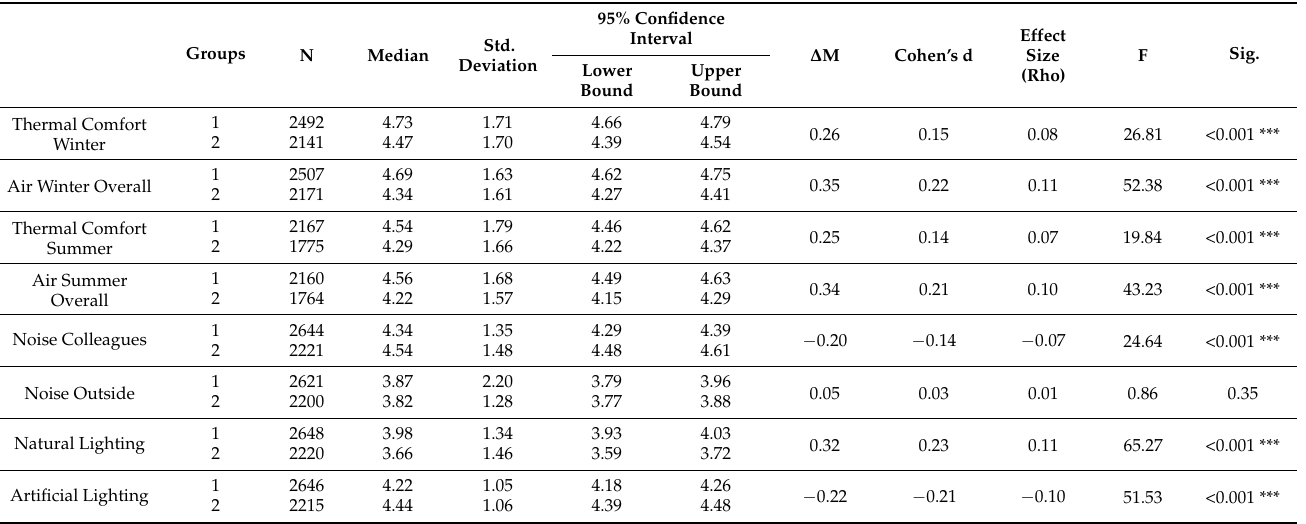
Table 4. Mean differences and effect size calculation comparing green and non-certified buildings regarding environmental